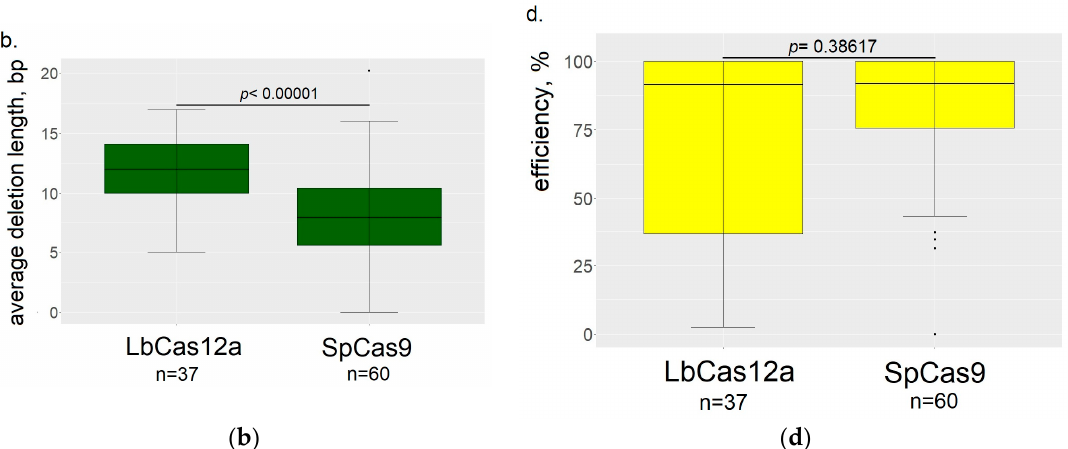
Figure 3. Comparison of LbCas12a and SpCas9 editing properties (the data from both serotonin transporters are summed together). ( a ) SpCas9 produces higher percentage of inserts in the outcomes of editing. ( b ) Average length of deletion is higher in embryos mutated by LbCas12a. ( c ) LbCas12a produces higher percentage of indels longer than 10 bp. ( d ) Both nucleases showed the same efficiency of editing.